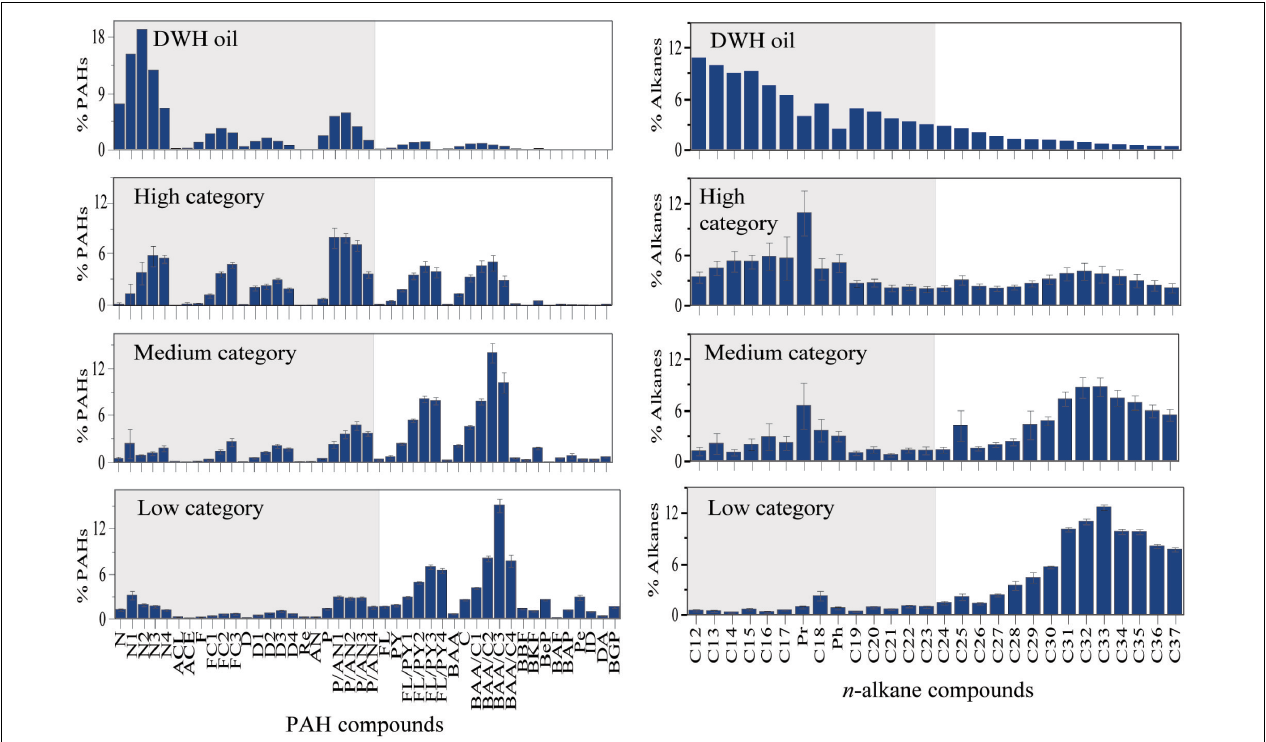
FIGURE 3 | Relative abundance of PAHs and n -alkanes by categories of %LMW compounds: high (PAHs: 68.0 ± 3.6%; alkanes: 63.9 ± 7.0%), medium (PAHs: 35.6 ± 5.0%; alkanes: 22.2 ± 6.0%), and low (PAHs: 20.1 ± 1.4%; alkanes: 10.9 ± 1.1%). Also, crude oil is shown as non-weathered DWH oil standard (NIST 2779). Contaminated sediments were collected in 2010–2011 in the nGoM (surface sediment layer). Data shown as mean ± 95% confidence